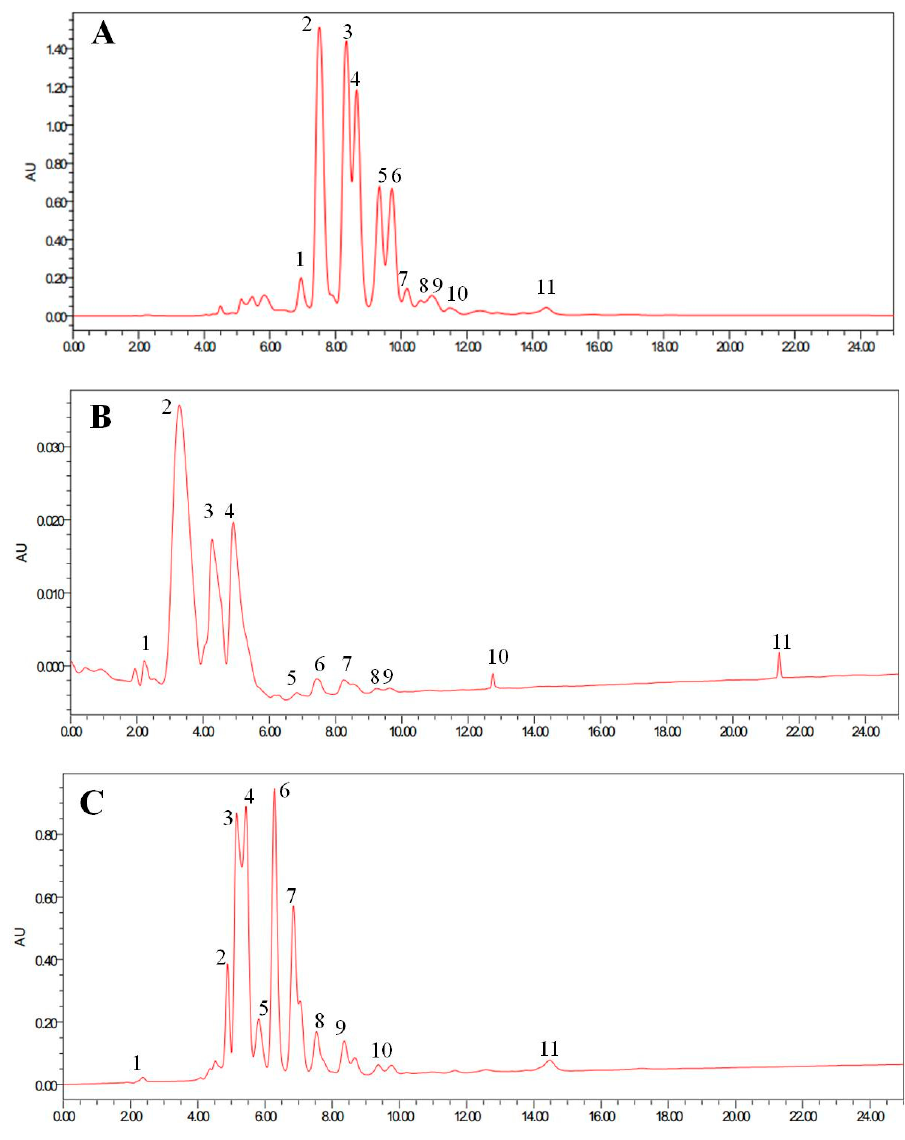
Figure 3. HPLC chromatograms of corn oil ( A ), SLs-U ( B ), and SLs-N ( C ).